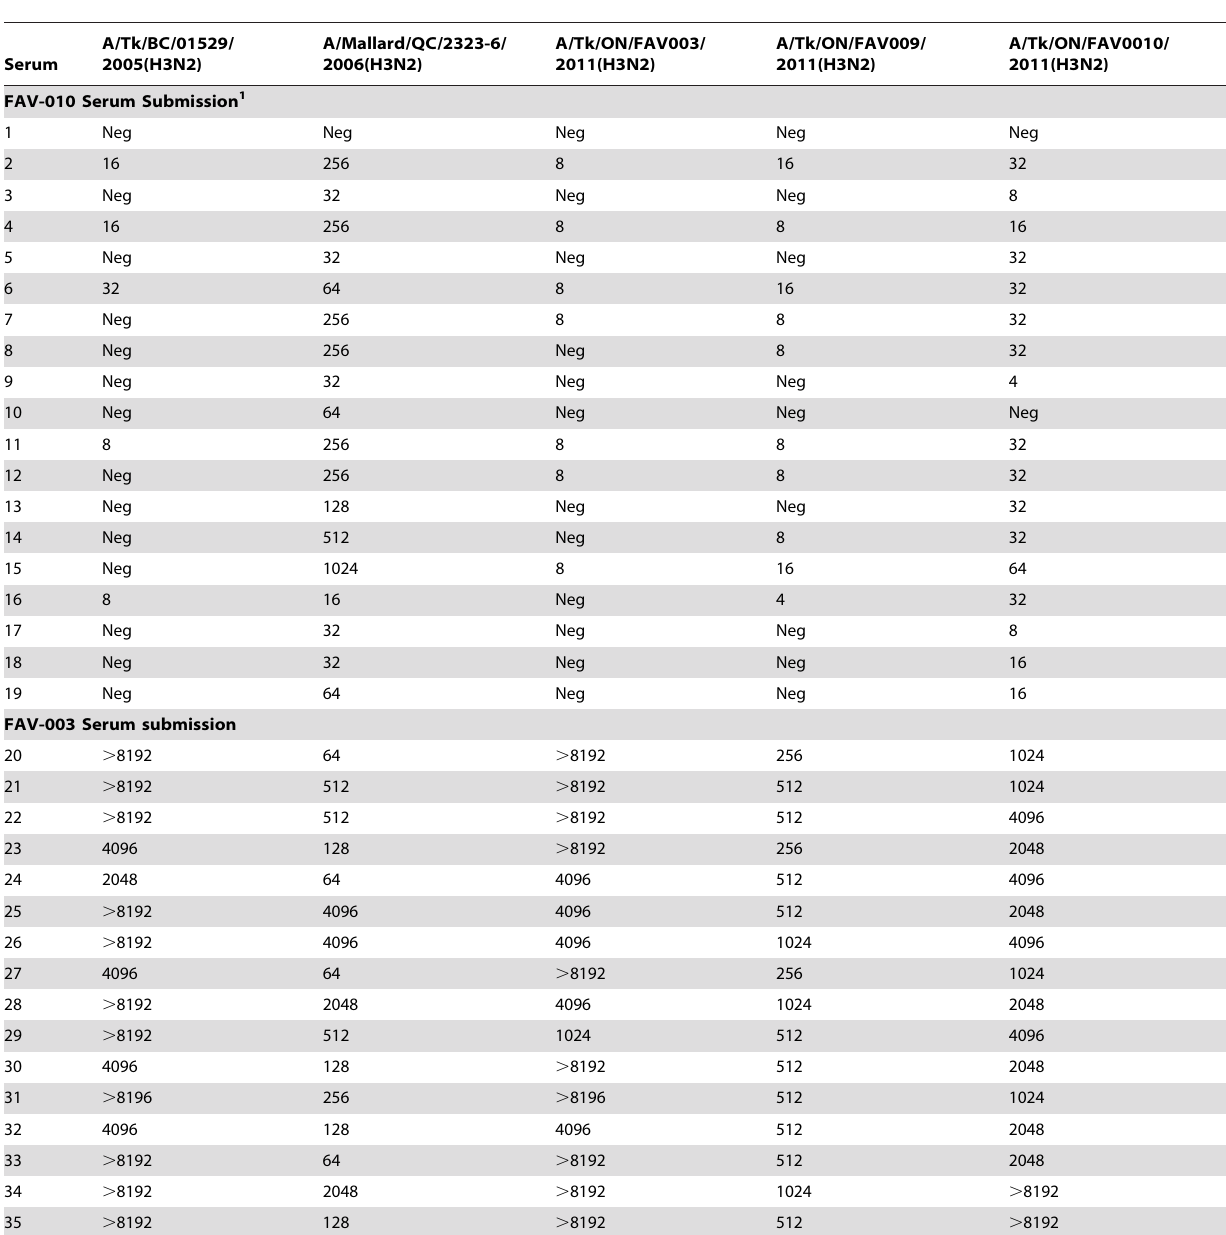
Table 2. Hemagglutination inhibition titres of pre-exposure serum samples submitted from turkeys vaccinated with H3N4 (FAV- 0010) and convalescent sera collected from turkeys exposed to triple reassortant H3N2 field virus